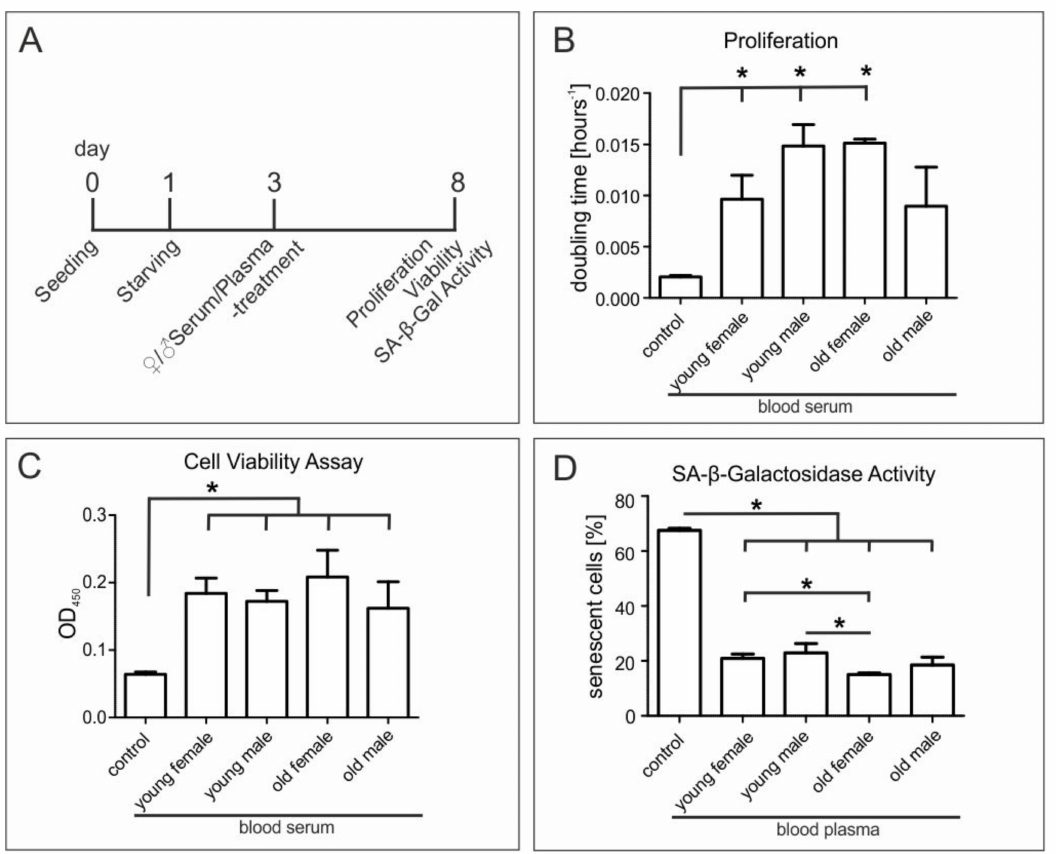
Figure 3. Application of di ff erent serum and plasma samples on adult human cardiac stem cells. ( A ) hCSCs were exposed to blood serum and blood plasma from old ( > 60 years) and young ( < 20 years) male and female donors or starvation medium. ( B ) Treatment with sera from young female, young male and old female donors significantly increased the proliferation of hCSCs. ( C ) Orangu cell viability assay to measure the metabolism of hCSCs showed increased metabolism after serum treatment but no sex or age dependency. ( D ) SA- β -Galactosidase assay showed a decrease of senescent cells after